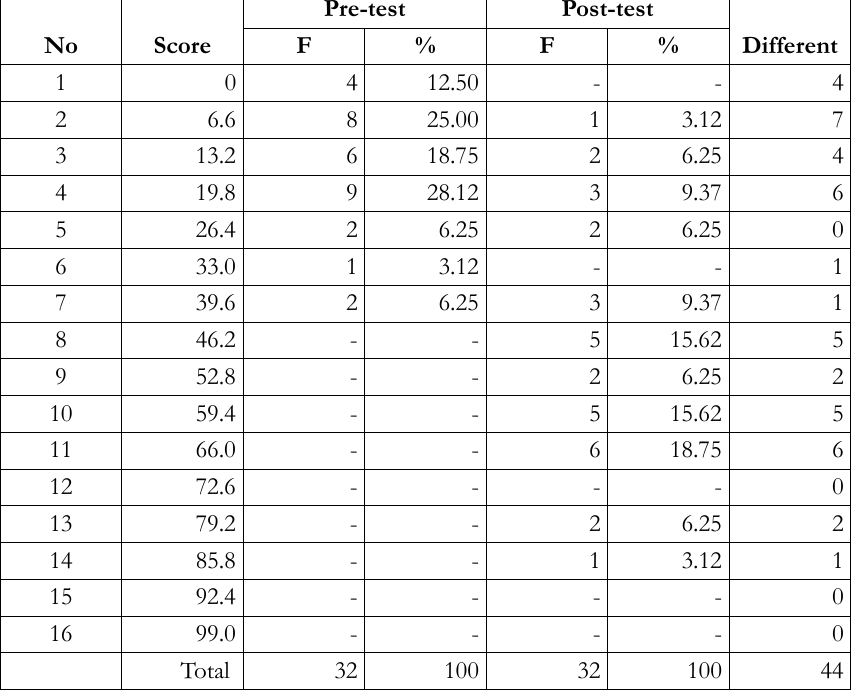
Table 5. Pre-test value and post-test in class x2 (Control